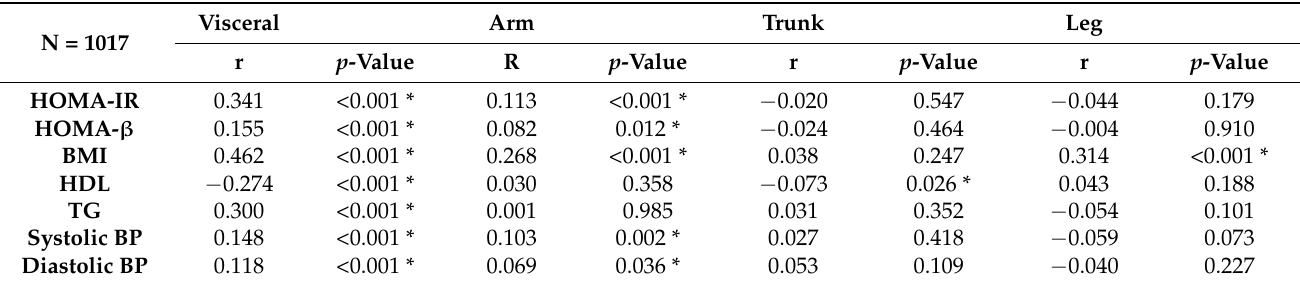
Table 7. Associations between regional adiposity and metabolic characteristics in premenopausal women.